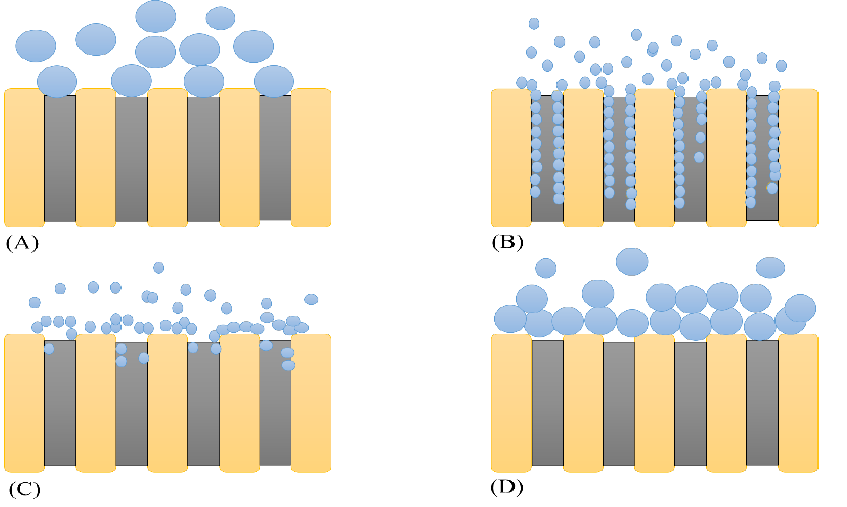
Figure 2. Types of fouling mechanisms: ( A ) complete blocking model, ( B ) standard blocking model, ( C ) intermediate blocking model, and ( D ) cake layer formation model.